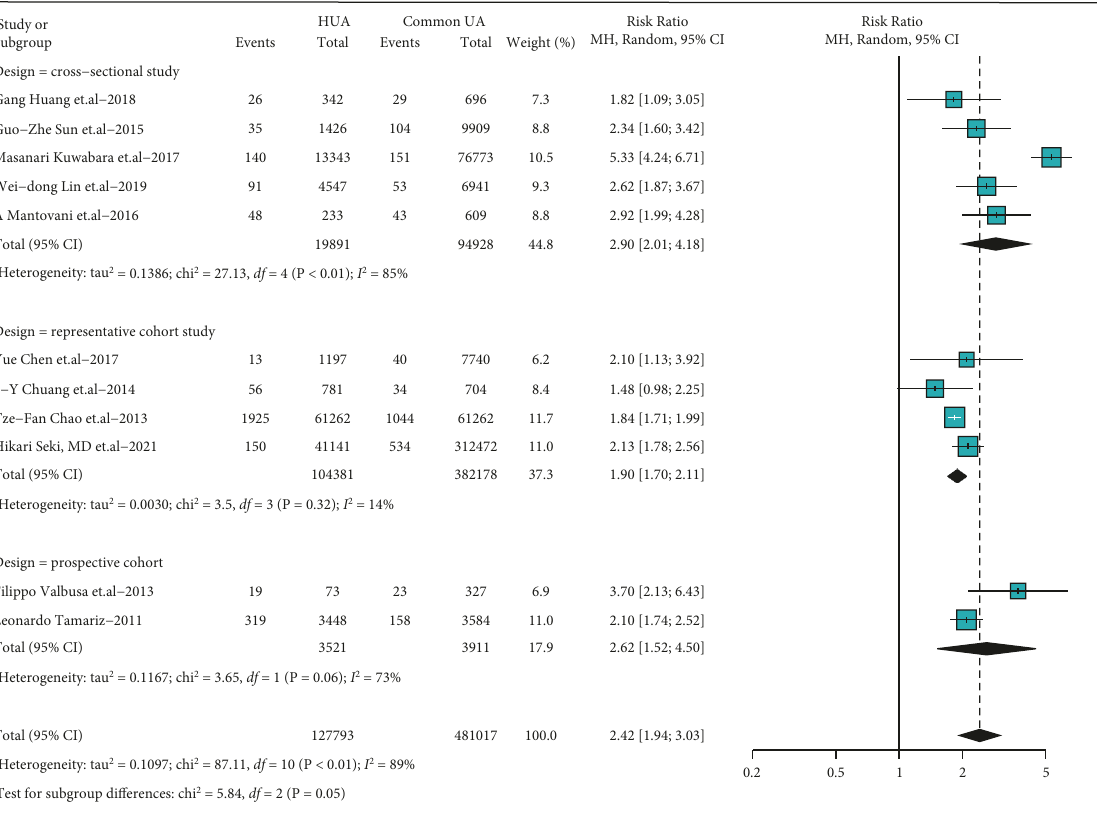
Figure 4: Associations between AF and HUA in studies of different designing. HUA: hyperuricemia, common UA: individuals without HUA; significance was set as P < 0 .